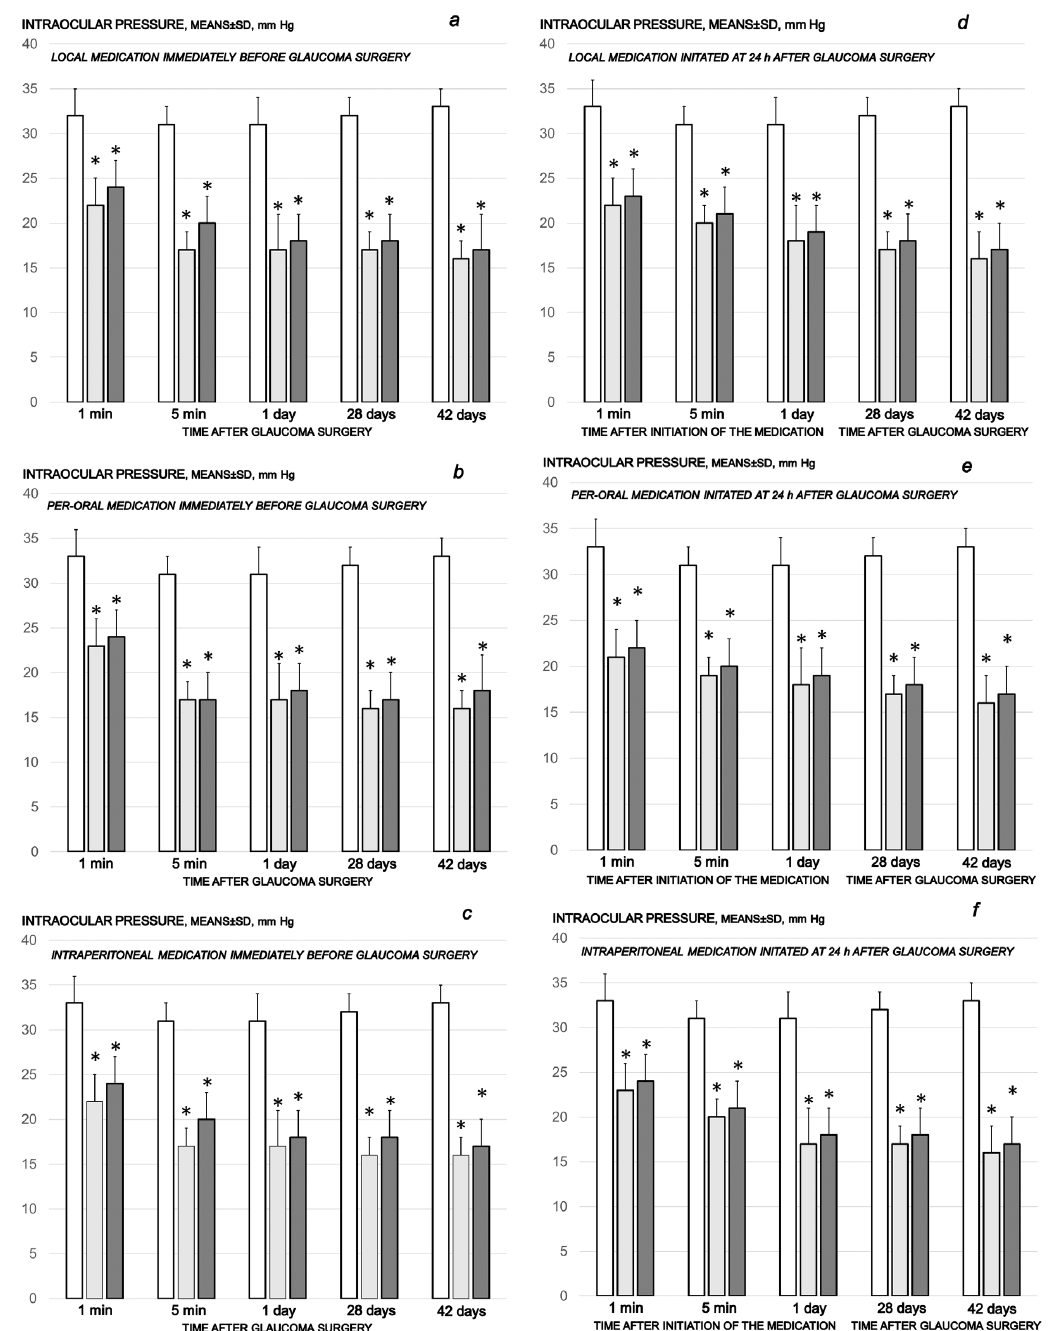
Figure 1. Cauterization of the three episcleral veins induced increased intraocular pressure, which remained sustained until the end of the of the experiment at the end of the sixth post-injury week. Counteracting effect of BPC 157 medication daily regimen, prophylactic ( a – c ) or curative ( d – f ) (gray bars, light gray bars µg-regimen, dark gray bars ng-regimen (0.4 µg/eye, 0.4 ng/eye; 10 µg/kg, 10 ng/kg) given locally as eye drops in each eye ( a , d ), intraperitoneally (last application at 24 h before sacrifice) ( b , e ) or per-orally in drinking water (0.16 µg/mL, 0.16 ng/mL, 12 mL/rat until the sacrifice, first application given intragastrically) ( c , f ), started prophylactically (immediately before glaucoma surgery) or as curative treatment (at 24 h after glaucoma surgery). Controls (white bars) simultaneously received an equal volume of distilled water (two drops/eye), saline intraperitoneal application (5 mL/kg) or per-oral drinking water (12 mL/day/rat). A total of 6 rats/group/interval. * p < 0.05, at least, vs.